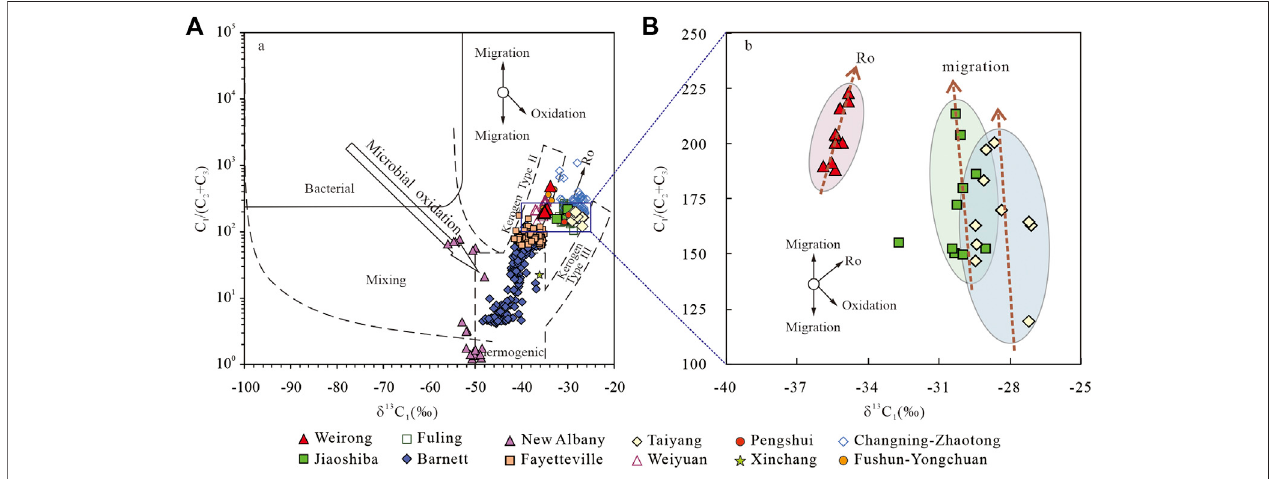
FIGURE 4 | Natural gas interpretative “ Bernard ” diagram (Bernard et al., 1976), showing gases from the Taiyang, Jiaoshiba, and Weirong gas fi elds are thermogenic gas (A) and the effects from migration and thermal maturation (B) . Also shown are shale gases from the published data (see text).